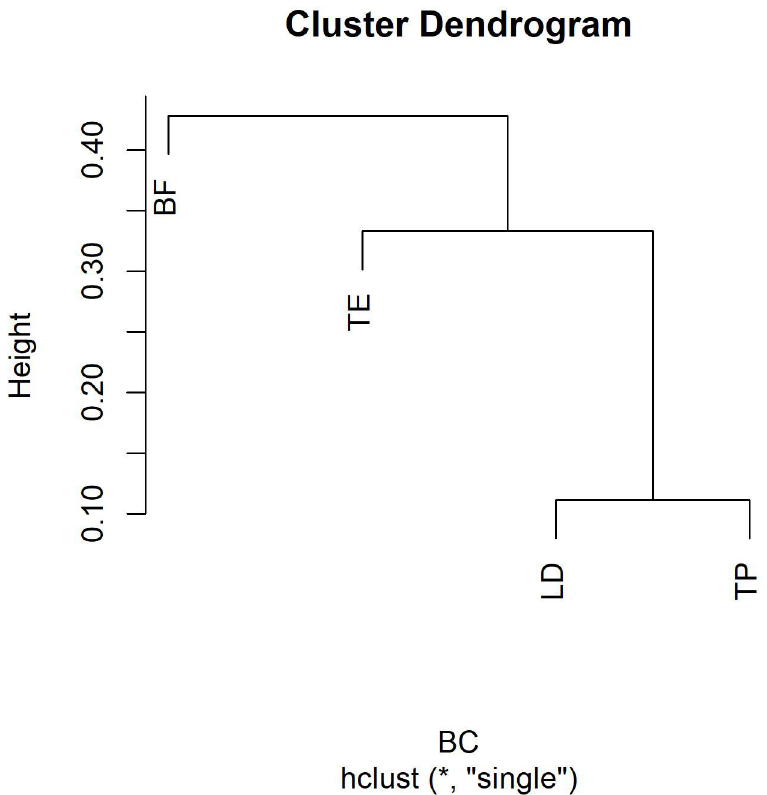
Fig 3. Cluster dendrogram using “single” agglomeration method, obtained based on Bryan-Curtis dissimilarity index matrix. The y -axis demonstrates a rescaled distance cluster combinations. (BF– Boletus fragrans , TE– Tricholoma equestre , TP– Tricholoma portentosum and LD– Lactarius deliciosus